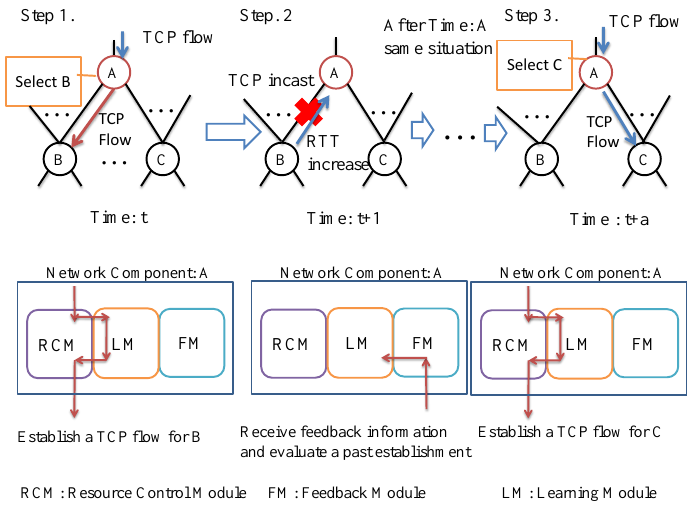
Figure 2. The architecture of the proposed scheme.